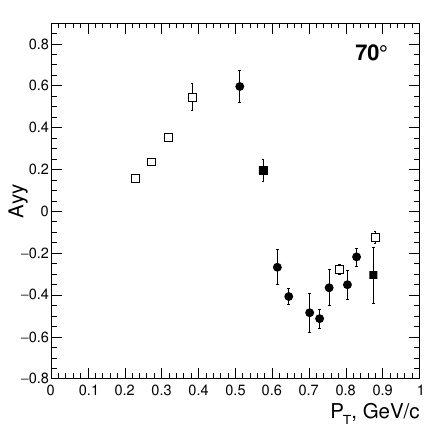
Figure 13. The energy dependence of the tensor analyzing power A yy at 70 ◦ in the c.m.s. The full circles are the preliminary results of the present experiment. The full squares are the data ob- tained at ITS at the Nuclotron in 2005 [14, 15]. Open symbols are the same as in Fig.